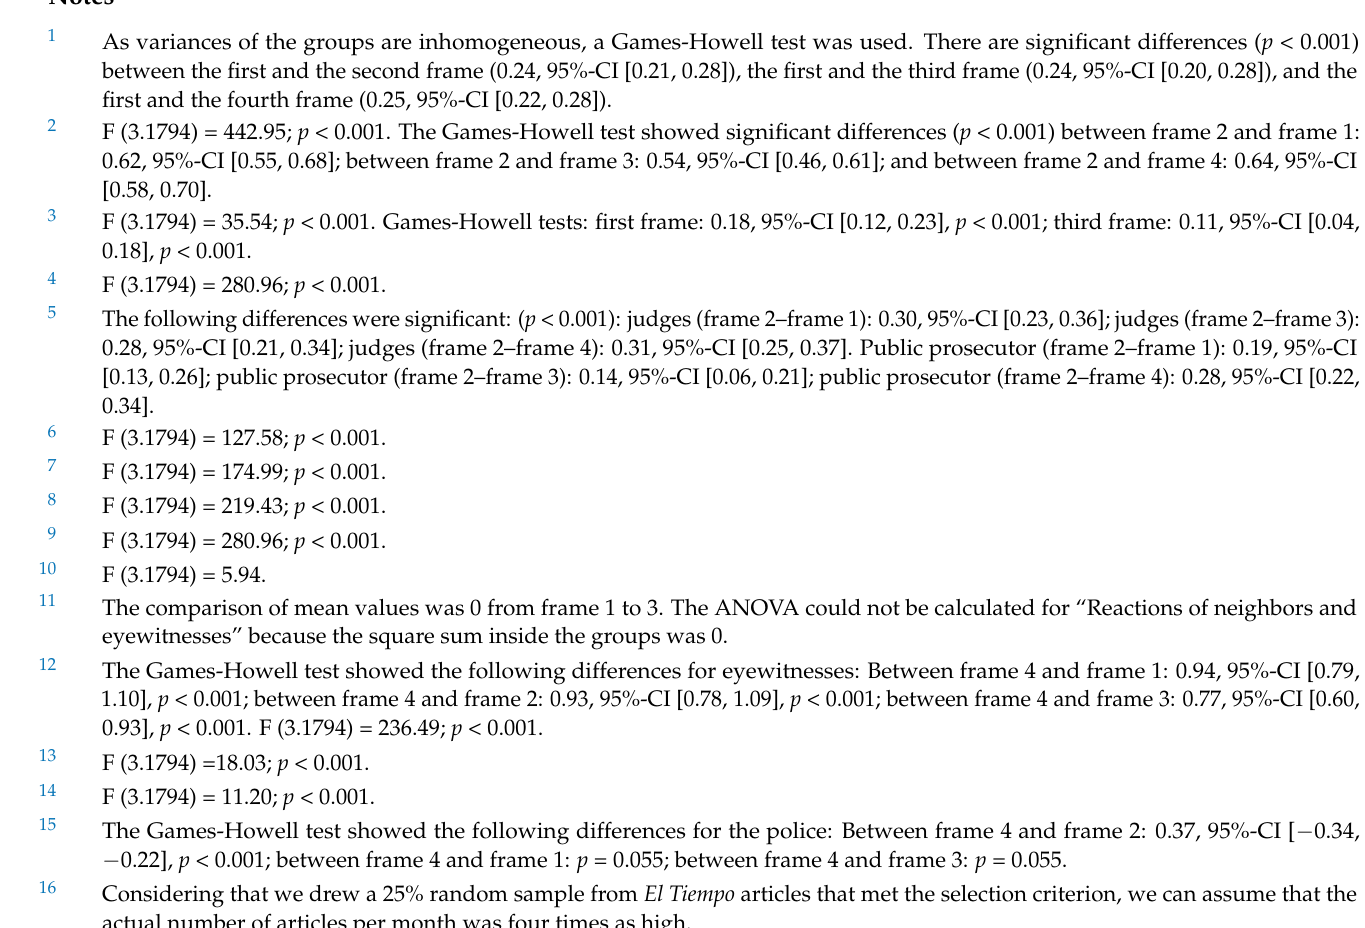
The Games-Howell test showed the following differences for the police: Between frame 4 and frame 2: 0.37, 95%-CI [ − 0.34, − 0.22], p < 0.001; between frame 4 and frame 1: p = 0.055; between frame 4 and frame 3: p = 0.055. Considering that we drew a 25% random sample from El Tiempo articles that met the selection criterion, we can assume that the actual number of articles per month was four times as